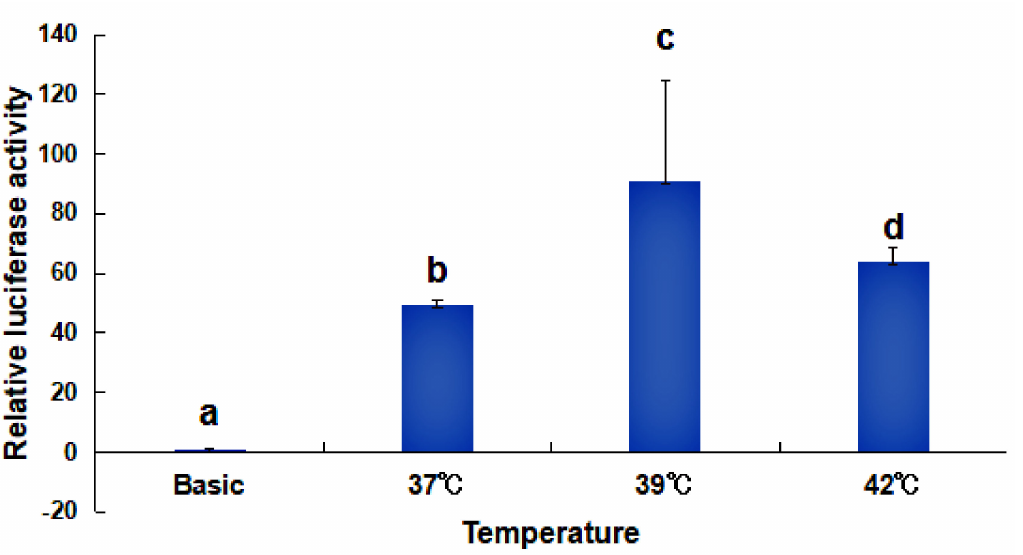
Figure 7. Changes of HdHSP70 promoter activity in HEK293FT cells under high temperatures. The cells were exposed to high temperatures (37 ◦ C, 39 ◦ C and 42 ◦ C) for 40 min. Values are means ± SD of biological replicates (n = 3). The different letters on the error bars indicate different significant differences, p <